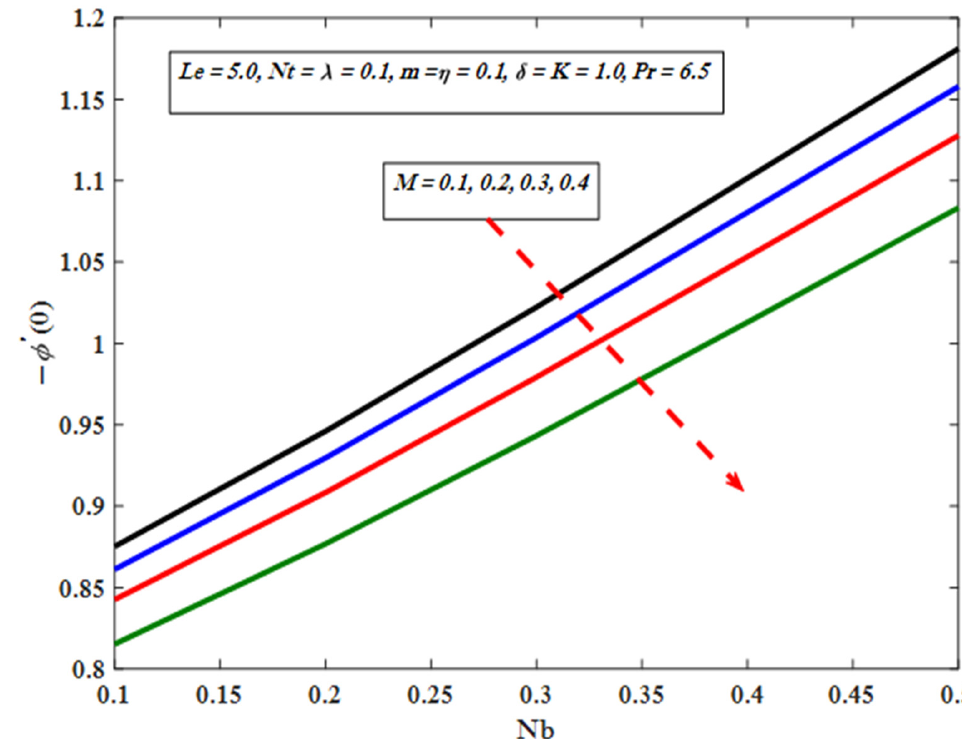
Figure 11. − φ (cid:48) ( 0 ) for various values of M and Nb . Figure 11. (cid:3398)𝜙′(cid:4666)0(cid:4667) for various values of M and 𝑁𝑏.